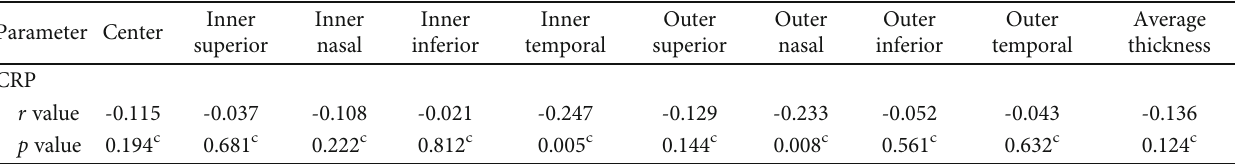
Table 4: Correlation analysis between CRP and retinal thickness.